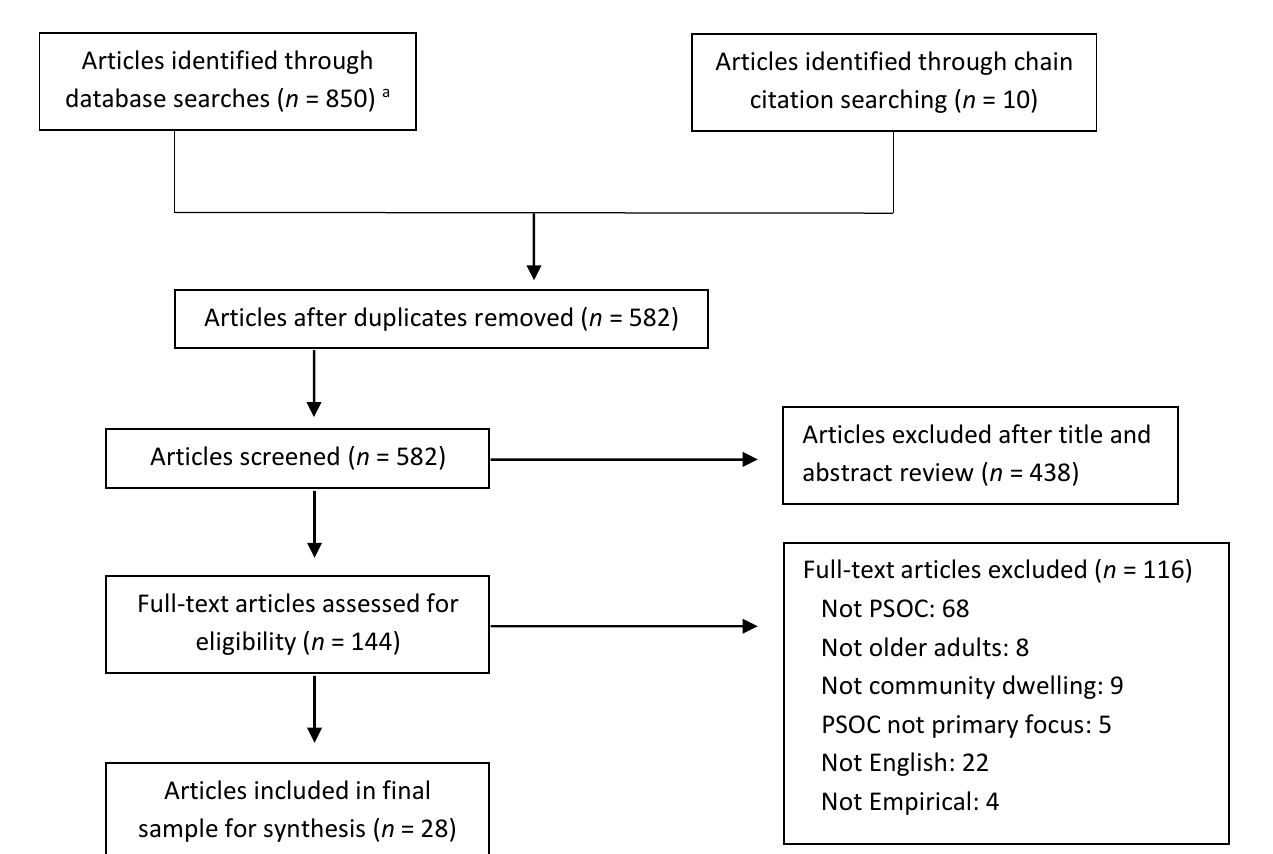
Figure 1. PRISMA Diagram for Search and Selection Process. Note . PRISMA = Preferred Reporting Items for Systematic Reviews, PSOC = psychological sense of community. a Databases searched ( n for each): EBSCO ( n = 398), Web of Science ( n = 283), ProQuest ( n = 161).